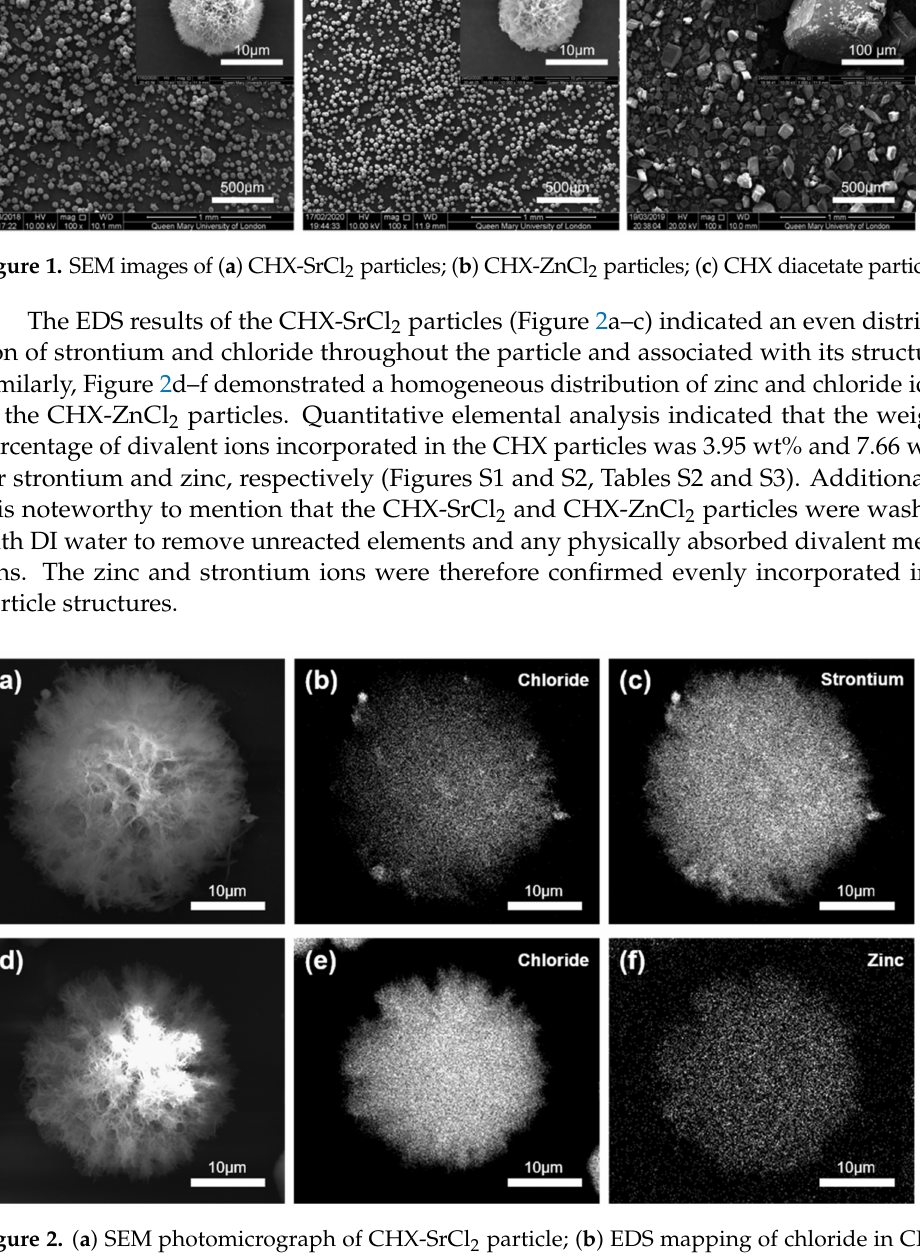
Figure 2. ( a ) SEM photomicrograph of CHX-SrCl 2 particle; ( b ) EDS mapping of chloride in CHX- SrCl 2 particle; ( c ) EDS mapping of strontium; ( d ) SEM photomicrograph of CHX-ZnCl 2 particle; ( e ) EDS mapping of chloride in CHX-ZnCl 2 particle; ( f ) EDS mapping of zinc. The FTIR results of the CHX-SrCl 2 , CHX-ZnCl 2 , and CHXD particles are shown in Figure 3. In the infrared spectrum of the CHXD, there are three absorption peaks at 3325 cm − 1 , 3120 cm − 1 , and 3180 cm − 1 , which may be attributed to the stretching vibrations N–H of the groups (Alkyl) 2 NH, Alkyl-NH-Aryl, and to the group =NH, respectively [46]. A typical band at 1612 cm − 1 can also be assigned to the stretching vibration of the imine group C=N [47,48]. The IR spectrum of the CHX-SrCl 2 and CHX-ZnCl 2 particles for the band of the imine group displays a positive shift from 1612 cm − 1 to 1623 cm − 1 . In addition, after forming the novel CHX particles, the stretching vibrations N–H of the groups (Alkyl) 2 NH and the group =NH showed significant shifts as well. Based on the comparisons between the infrared spectrums of the CHX-SrCl 2 , CHX-ZnCl 2 particles, and CHXD,